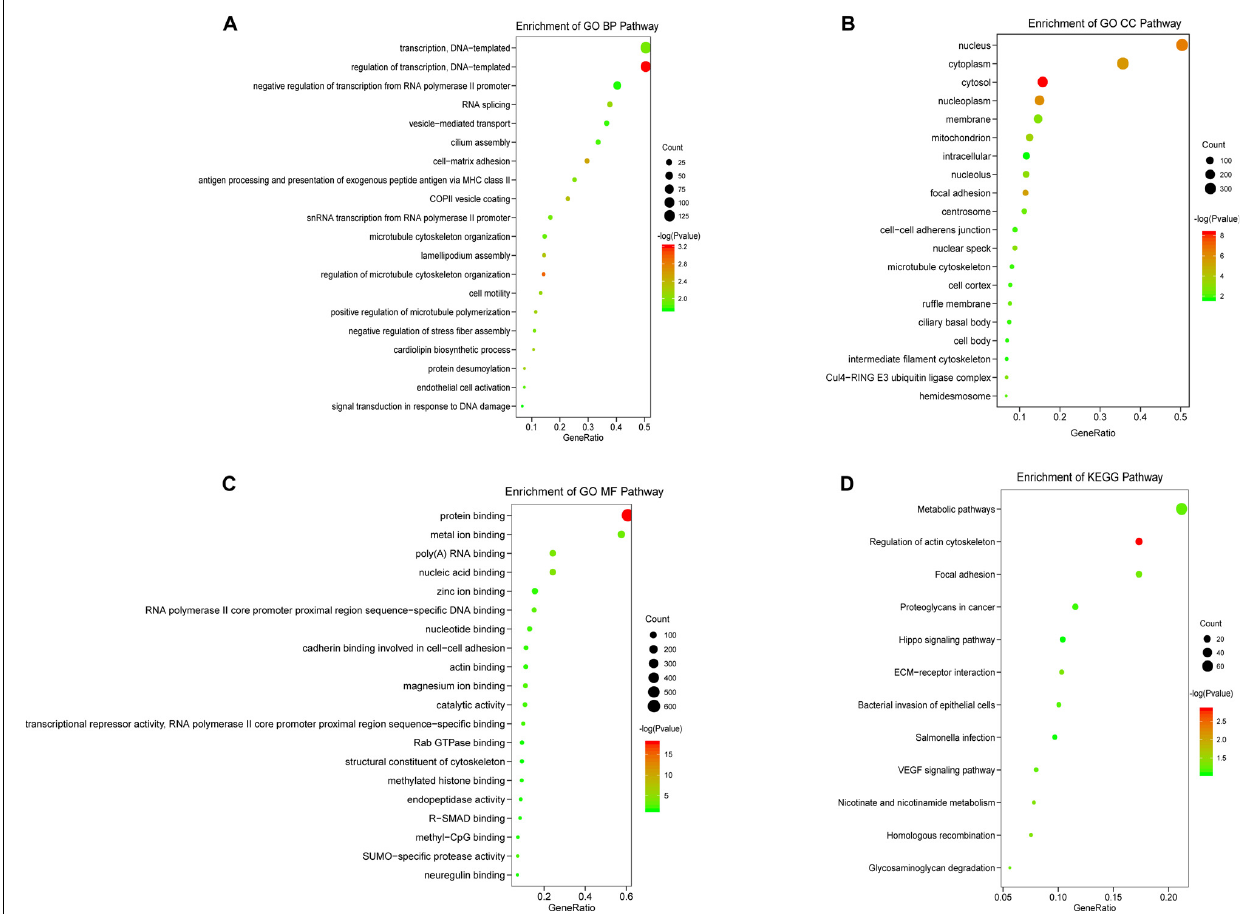
FIGURE 3 | KEGG and GO pathways for TNBC prognosis-associated AS genes. The vertical axis represents GO or KEGG pathway annotations. The horizontal axis represents the number of genes assigned to the corresponding annotated pathway. (A) The top 20 significant terms of BP in GO. (B) The top 20 significant terms of CC in GO. (C) The top 20 significant terms of MF in GO. (D) The top 12 terms of KEGG